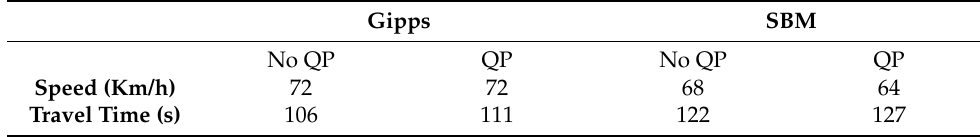
Table 4. Average travel time and average speed in the section that incident